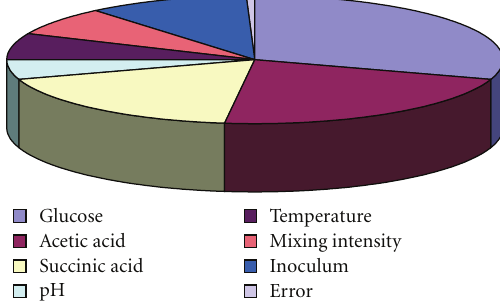
Figure 2: The relative influence of factors and